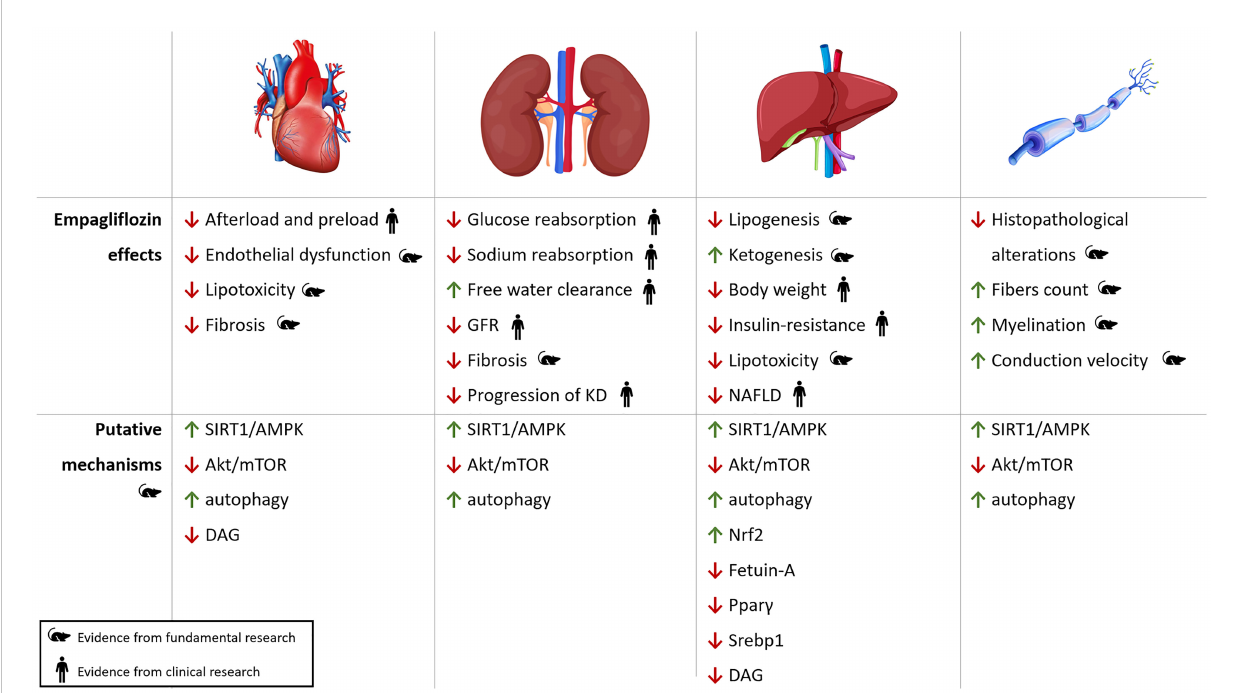
FIGURE 3 Pleiotropic effects of empagli fl ozin. Cardiac, renal, hepatic and neuropathic effects of empagli fl ozin with putative molecular pathways involved in oxidative stress, autophagy and in fl ammation. KD, kidney disease; NAFLD, Non-Alcoholic Fatty Liver Disease; ROS, reactive oxygen